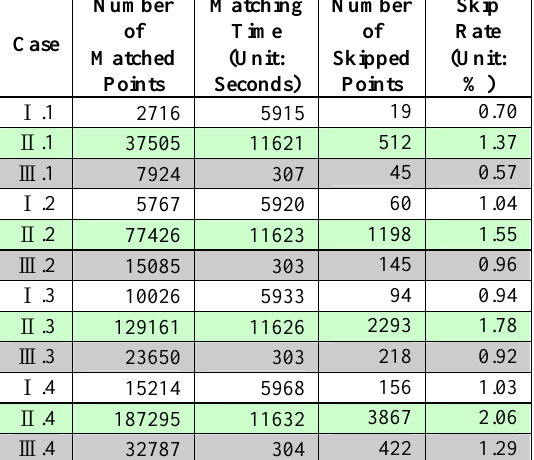
Table 5. Number of N-fold tie points